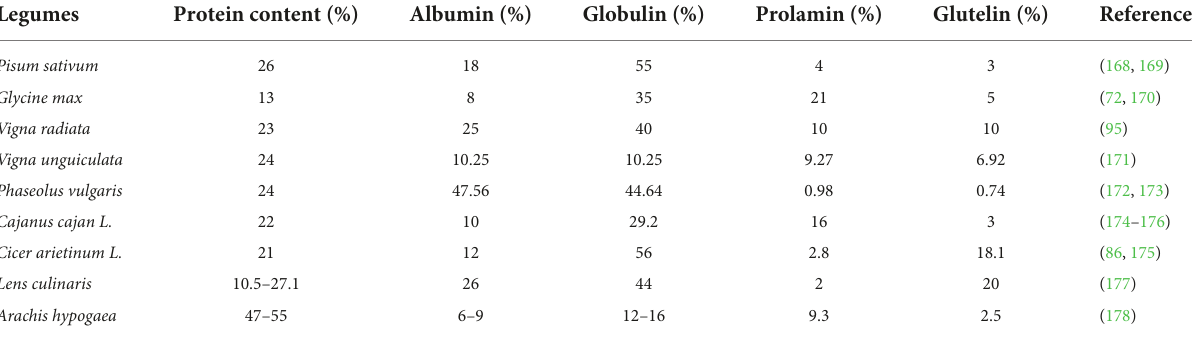
TABLE 2 Protein composition of different legumes and their comparison with lentil and peanut.